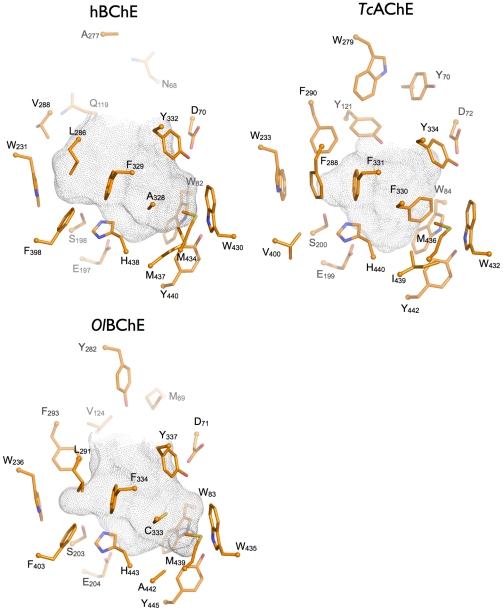
Active site gorges of H. sapiens BChE (hBChE; pdb code 1p0i), T. californica AChE (TcAChE; pdb code 1ea5) and a homology model of O. latipes atypical BChE (OlBChE).The side chains of key residues lining the gorges are represented as sticks (carbon in orange, oxygen in red, and nitrogen in blue). The top of the gorge and the entrance to and exit from the enzyme are shown at the top of the figures. The acyl pocket, which accommodates the acyl group of substrates, is comprised of residues F288 and F290 in T. californica AChE, L286 and V288 in H. sapiens BChE, and L291 and F293 in O. latipes AChE. The central residue of the choline binding site at the bottom of the gorge is W84 in T. californica AChE, W82 in H. sapiens BChE, and W83 in O. latipes atypical BChE. Substrates are bound between these two subsites. The solvent accessibility surface of the gorge was calculated by taking into account highly conserved structural water molecules, using the software “HOLLOW” and represented as grey dots [99].